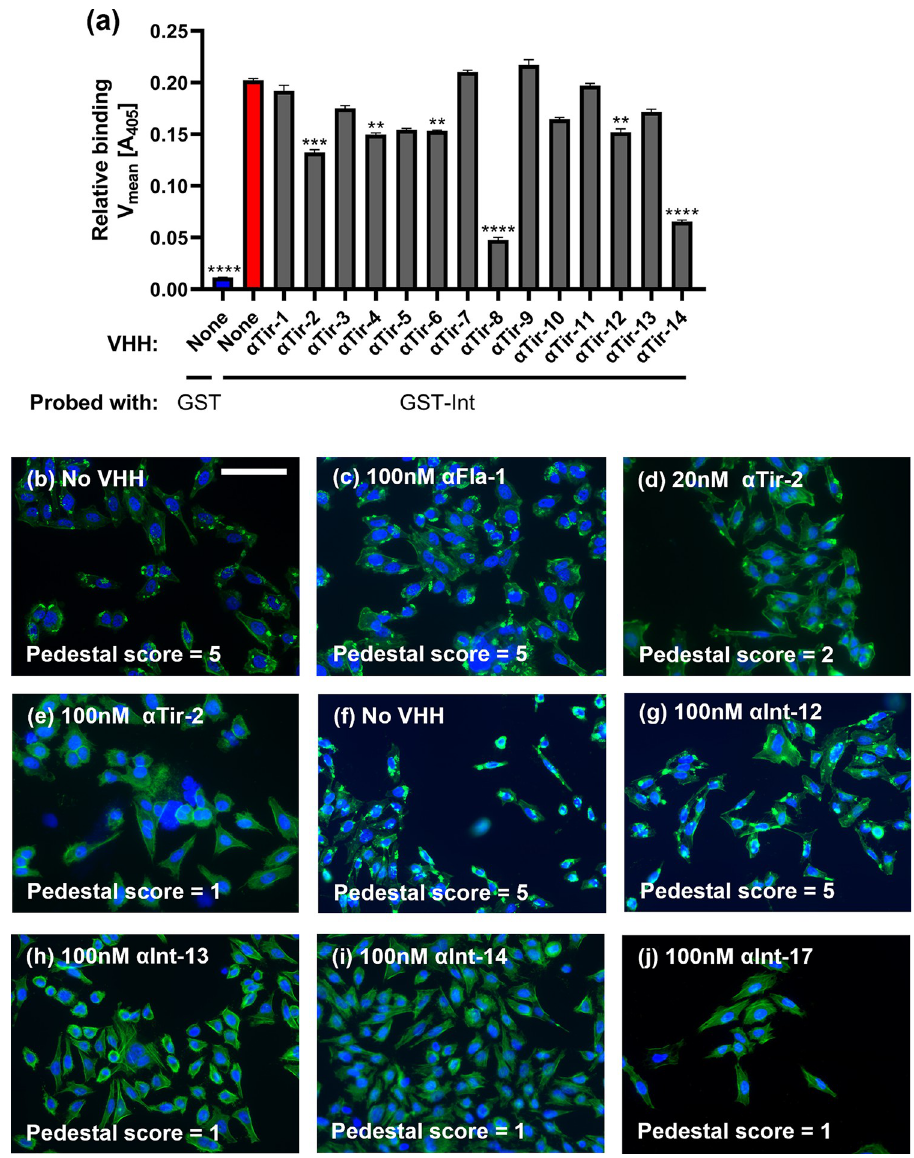
Fig 3. Anti-Tir and anti-intimin VHHs interfere with Tir-intimin binding and pedestal formation. (a) Several anti-Tir VHHs blocked Tir-intimin binding. Data presented as mean ± SEM. P-values calculated by one-way ANOVA. �� P < 0.01; ��� P < 0.001, ���� P < 0.0001. (b-j) Anti-Tir and anti-intimin VHHs can inhibit EPEC-mediated pedestal formation (scale bar = 100 μ m). HeLa cells were exposed to EPEC incubated with VHH, fixed, and stained with DAPI (blue) and Alexa Fluor-488 Phalloidin (green). Blinded pedestal scores were assigned by a separate